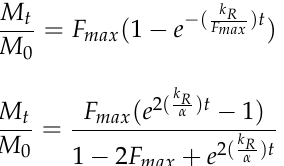
Table 2. Fitting parameters for CUR release from hybrid ( H C